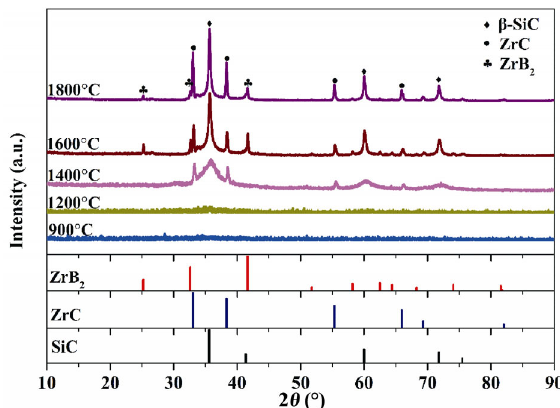
Fig. 5 XRD patterns of the ABZ-1 derived ceramics annealed at different temperatures.